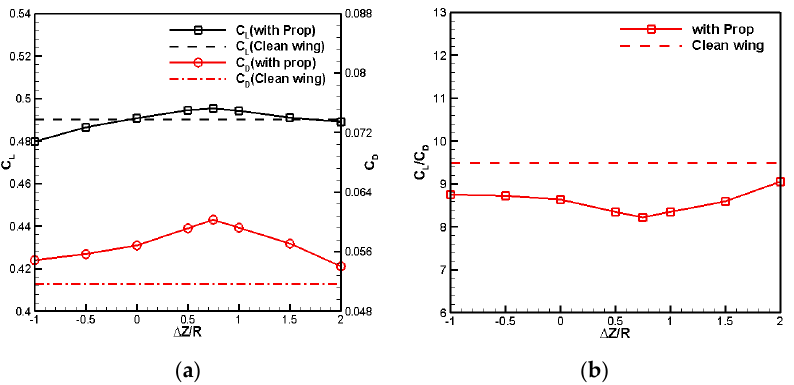
Figure 4. A tractor propeller ‐ wing configuration: ( a ) Oblique view; ( b ) side view.